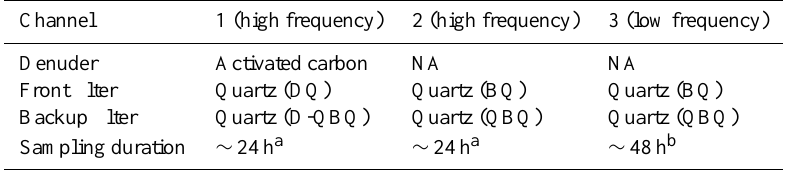
Table 1. Configuration of the SASS sampler (only the three channels used in this study are shown). Samples from channels 1 and 2, which are collected at a relatively high frequency, are referred to as high-frequency samples for simplicity; correspondingly, samples from channel 3 are termed low-frequency ones. This does not necessarily mean that 24h averaged sampling should be considered as high-frequency sampling elsewhere. Channel 1 (high frequency) 2 (high frequency) 3 (low frequency) Denuder Activated carbon NA NA Front filter Quartz (DQ) Quartz (BQ) Quartz (BQ) Backup filter Quartz (D-QBQ) Quartz (QBQ) Quartz (QBQ)